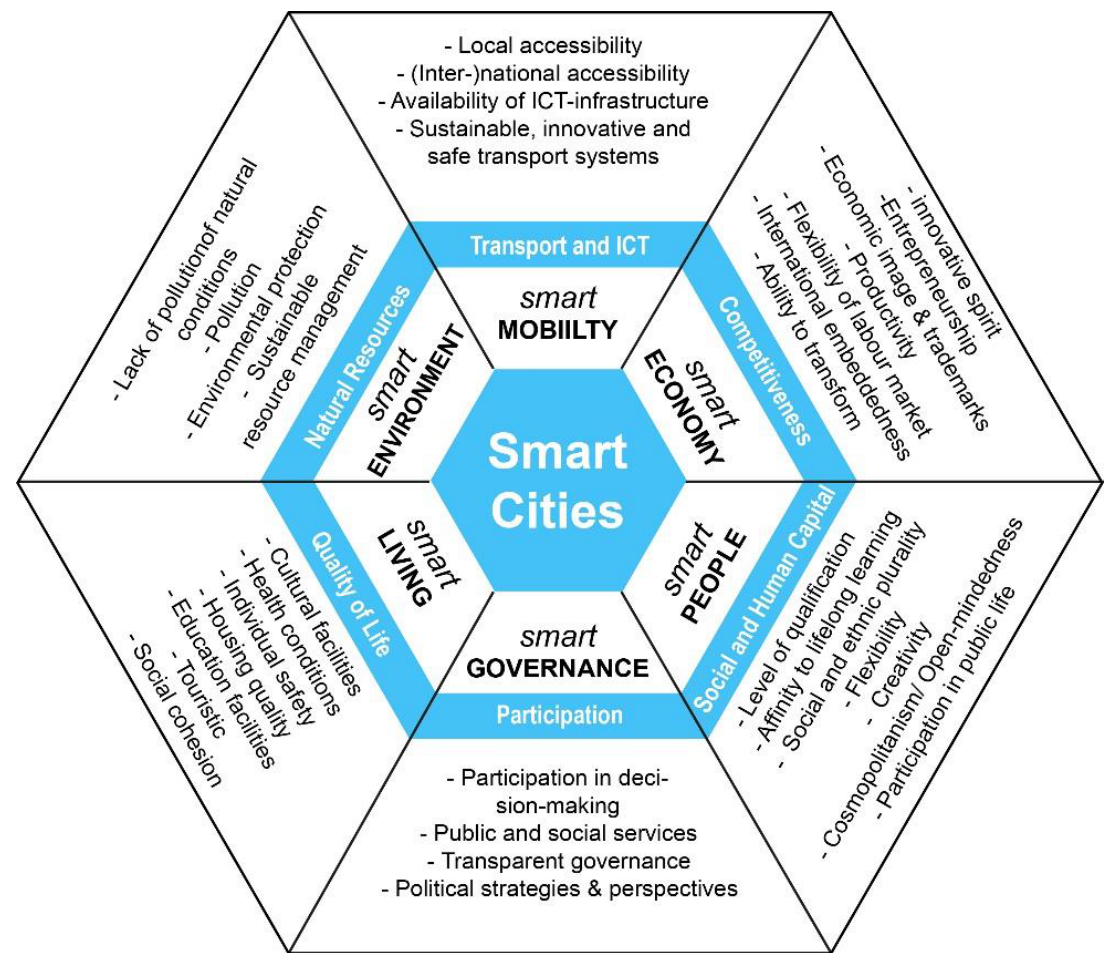
Figure 7. Smart cities ’ dimensions and indicators according to Giffinger. Source: [35]. Adapted by the author.